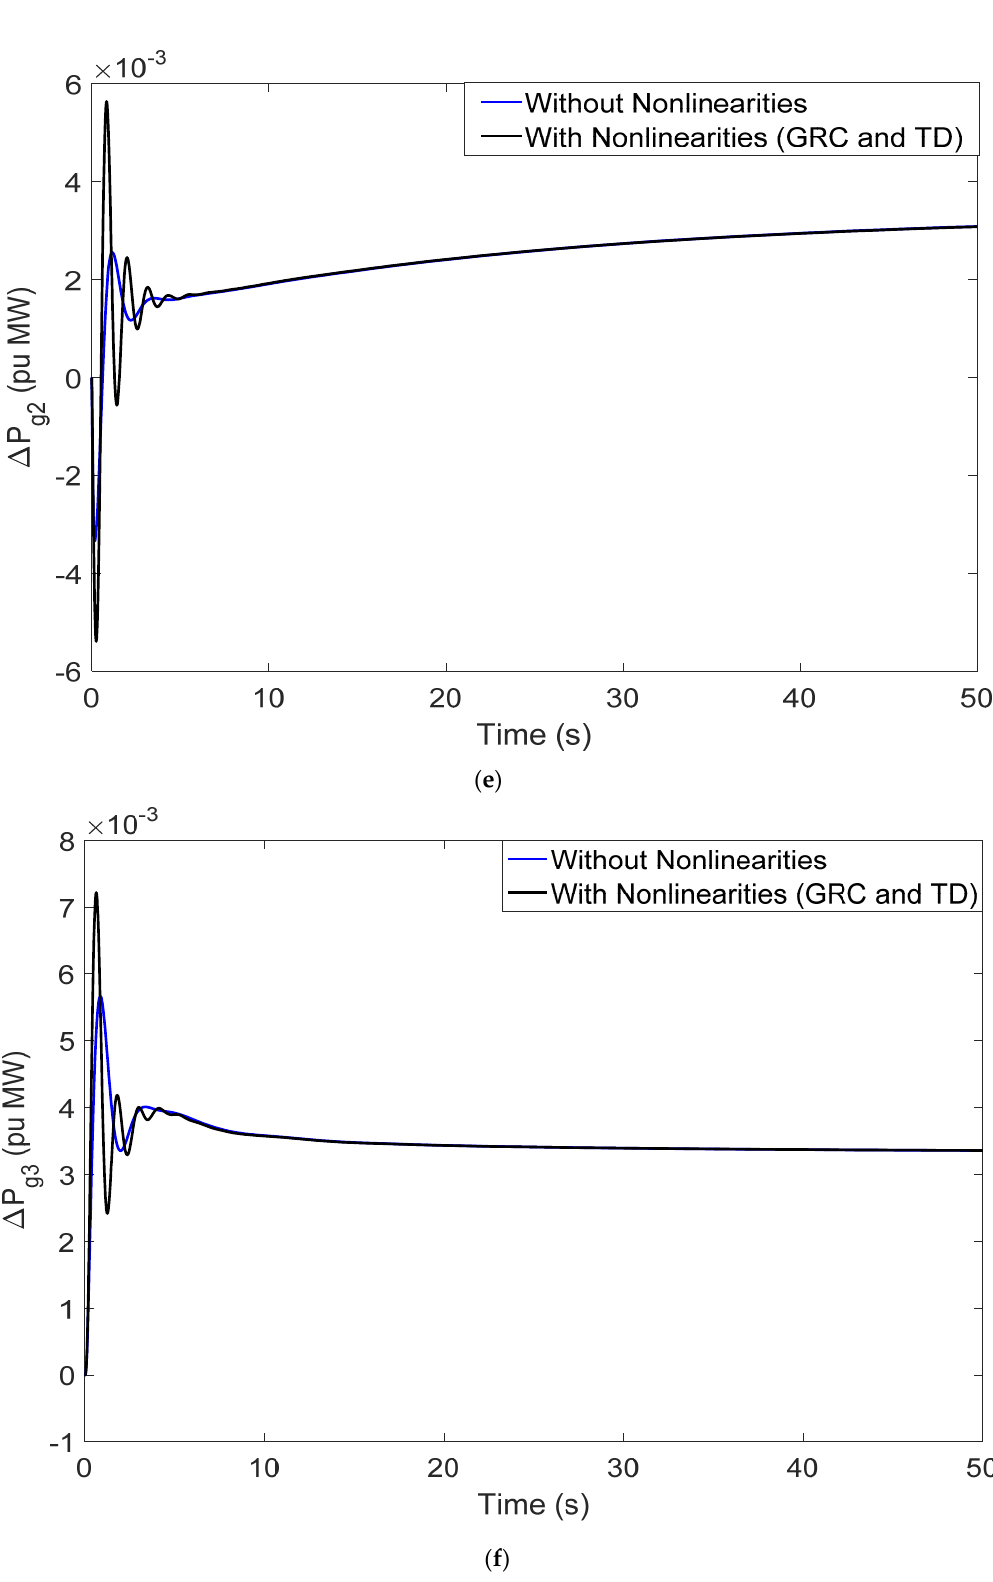
Figure 10. ( a ) Perturbation response ( Δ F 1 ) with and without (GRC and TD); ( b ) perturbation re- sponse ( Δ F 2 ) with and without (GRC and TD); ( c ) perturbation response ( Δ P tie ) with and without (GRC and TD); ( d ) perturbation response ( Δ P g1 ) with and without (GRC and TD); ( e ) perturbation TD); ( d ) perturbation response ( ∆ P g1 ) with and without (GRC and TD); ( e ) perturbation response response ( Δ P g2 ) with and without (GRC and TD); ( f ) perturbation response ( Δ P g3 ) with and without ( ∆ P g2 ) with and without (GRC and TD); ( f ) perturbation response ( ∆ P g3 ) with and without (GRC (GRC and TD). and